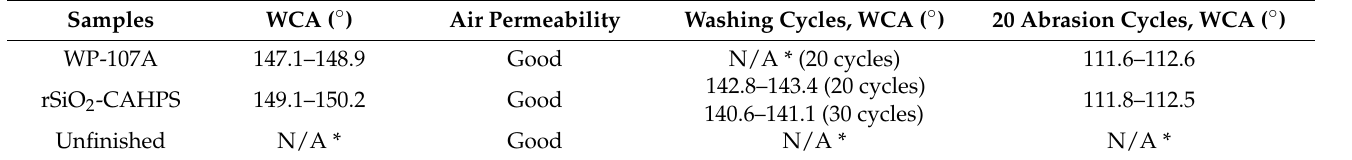
Table 2. The performance comparison with commercially available water